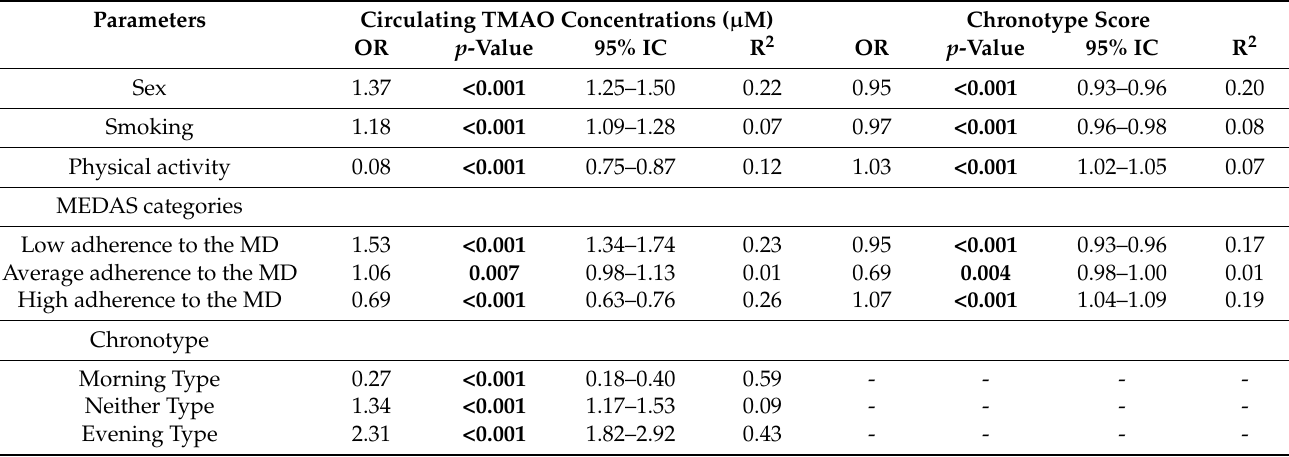
Table 5. Bivariate proportional odds ratio model to assess the association between both circulating TMAO concentrations and chronotype score with sex, lifestyle habits, MEDAS/chronotype categories.